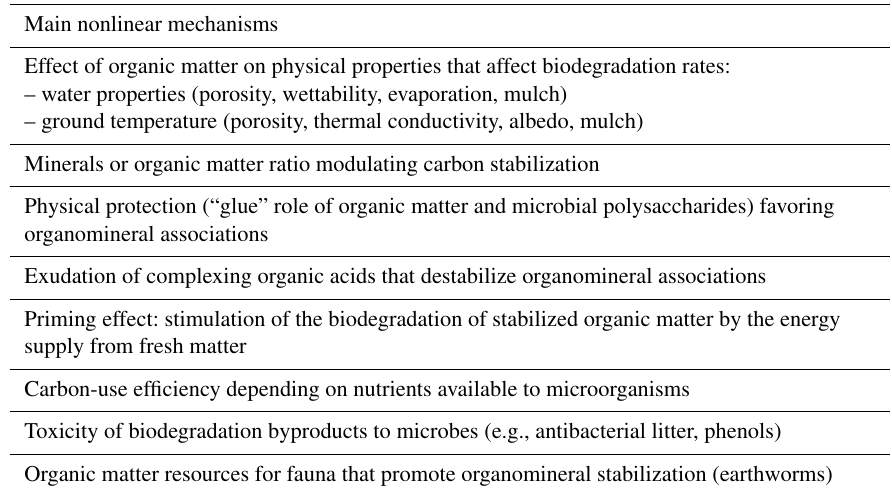
Figure 5. (a) Simplified kinetic representation of the fate of plant organic inputs in soil (single input event, here 5tCha − 1 yr − 1 ). The kinetics are divided into three mineralization phases: fast, intermediate and slow. Organic matter can be divided into three corresponding pools, the size of which is represented in the figure by the colored areas. The sizes of the pools inherited from the inputs at year 0 decrease progressively with their own kinetics over 30 years. (b) Pool sizes were calculated based on 30 years of yearly inputs (with fluxes between pools). The numerical values are typical of the 0–30cm layer of temperate crops. Old carbon represents organic material inherited from a distant past. Table 1. Possible nonlinear mechanisms of carbon decomposition or accumulation. Due to these mechanisms, decomposition rates are dependent on the amounts of carbon supplied or present. These processes can interact with each